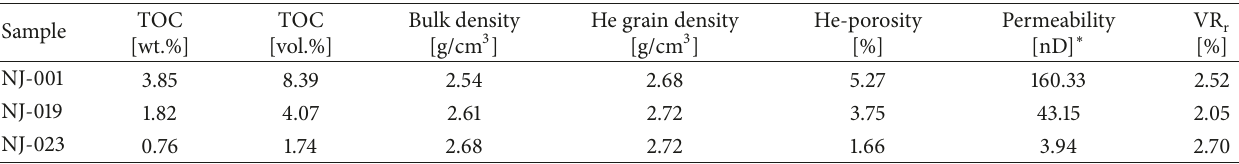
Table 2: Petrophysical measurements of the investigated samples featuring elemental analysis, helium pycnometry (He), non-steady-state gas